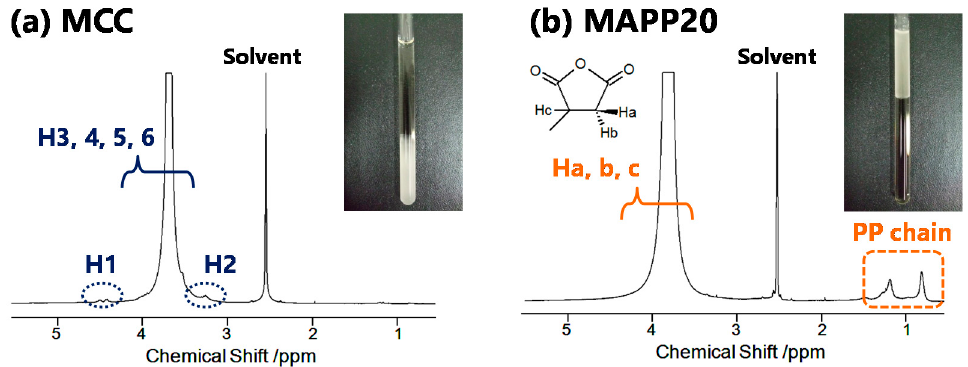
Figure 5. 1 H NMR spectra of ( a ) MCC and ( b ) MAPP20 immersed in a DMSO- d 6 /pyridine- d 5 (4/1, v / v ) mixed solvent system. The photograph of the NMR sample tube used for each measurement is also shown.